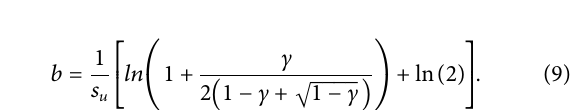
Frontiers in Earth Science |